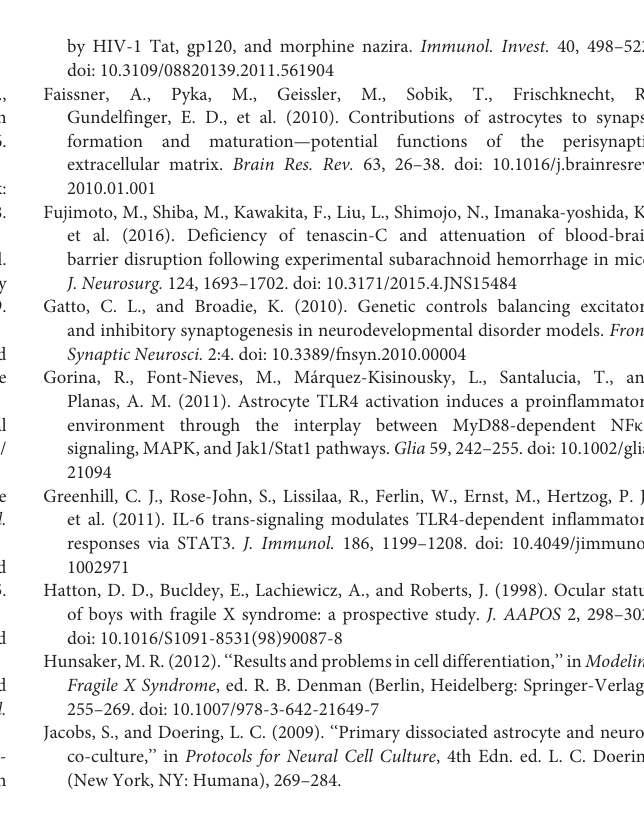
FIGURE S1 | Cellular localization of IL-6 in WT and FMR1 KO astrocytes treated with exogenous TNC, LPS and LPSRS. Extracellular astrocyte expression of secreted IL-6 in WT ( n = 6/group) and FMR1 KO ( n = 6/group) astrocyte cell cultures grown for 7 days in vitro . The culture was treated with LPS (10 µ g/mL), exogenous TNC (10 µ g/mL) and LPS-RS (10 µ g/mL) prior to ACM concentration and collection. Cultured cortical astrocytes co-labeled with 4’, 6-diamidino-2-Phenylindole (DAPI; blue) and anti-IL-6 (red) after 3 days in vitro , following treatment. Images were obtained using a 40 × objective with a Zeiss Axioimager M2. Scale bars = 10 µ